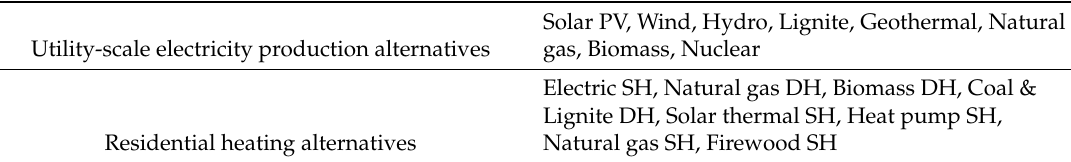
Table 2. Selected electricity production and heating alternatives. SH = Stand-alone Heating, DH = District